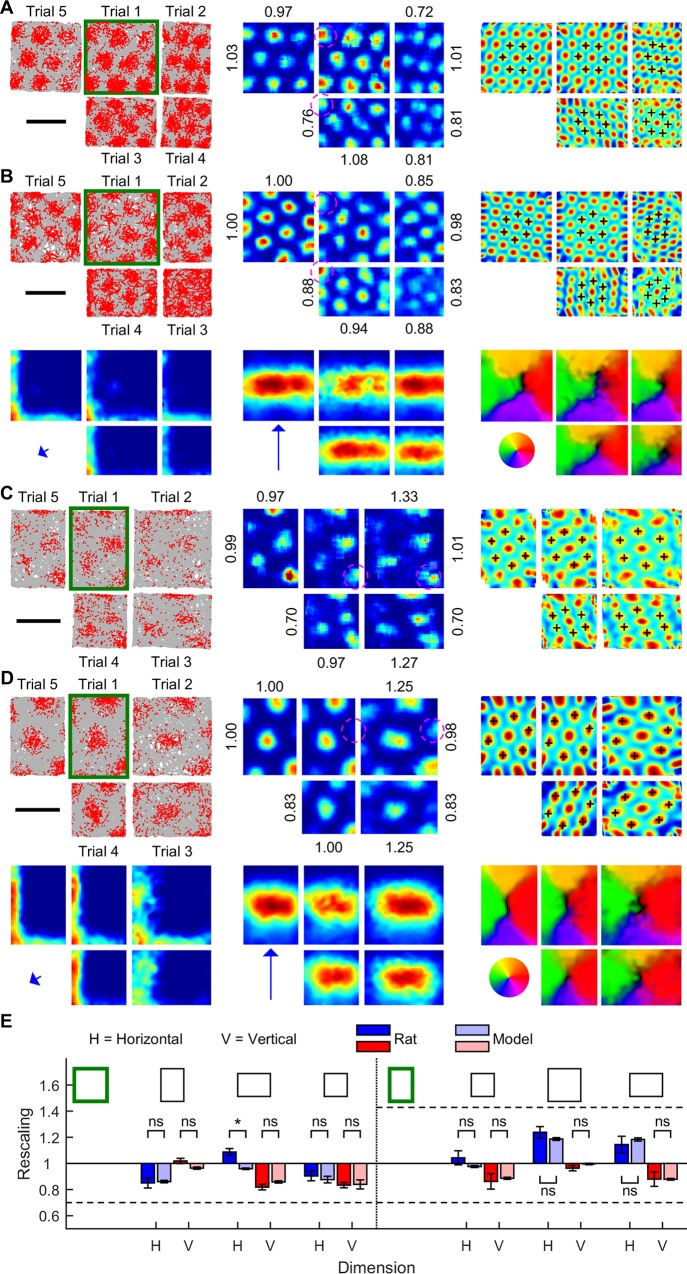
Partial rescaling of grid and boundary fields during arena resizing.(A) Grid cell data from a rat trained in a 1 m square arena (Trial 1), tested in three contracted arenas, and retested in the familiar arena. Rate maps (middle) and autocorrelograms (right) show partial grid rescaling principally along the contraction axes (full rescaling = 0.70, no rescaling = 1.00), causing partial loss of grid peaks (dashed circles). (B) Probabilistic grid cell data showing partial rescaling along arena compression axes. Typical predictive boundary cell responses (lower left–short-range, lower middle–long-range) showing stable boundary alignment across arenas, consistent with globally stable boundary vector maps (lower right). (C) Rat grid cell data—as per (A), but training in a 100 × 70 cm arena (Trial 1), and testing in both expanded and contracted arenas. Arena expansion causing partial gain of grid peaks (dashed circles; full rescaling = 0.70 (contraction) or 1.42 (expansion), no rescaling = 1.00). (D) Probabilistic grid cell data—as per (B), training in a 100 × 70 cm arena (Trial 1). (E) Grid rescaling magnitude (mean ± SEM; dashed line, magnitude of environmental rescaling; all P > 0.05 except horizontal rescaling dimension of Trial 3 in (A), P = 2.5×10−3, t44 = 4.6, two-sample t-tests, FDR corrected). (A-E) Scale bars, 50 cm. Rat data was previously published [34], with permission from C. Barry and K. Jeffery.